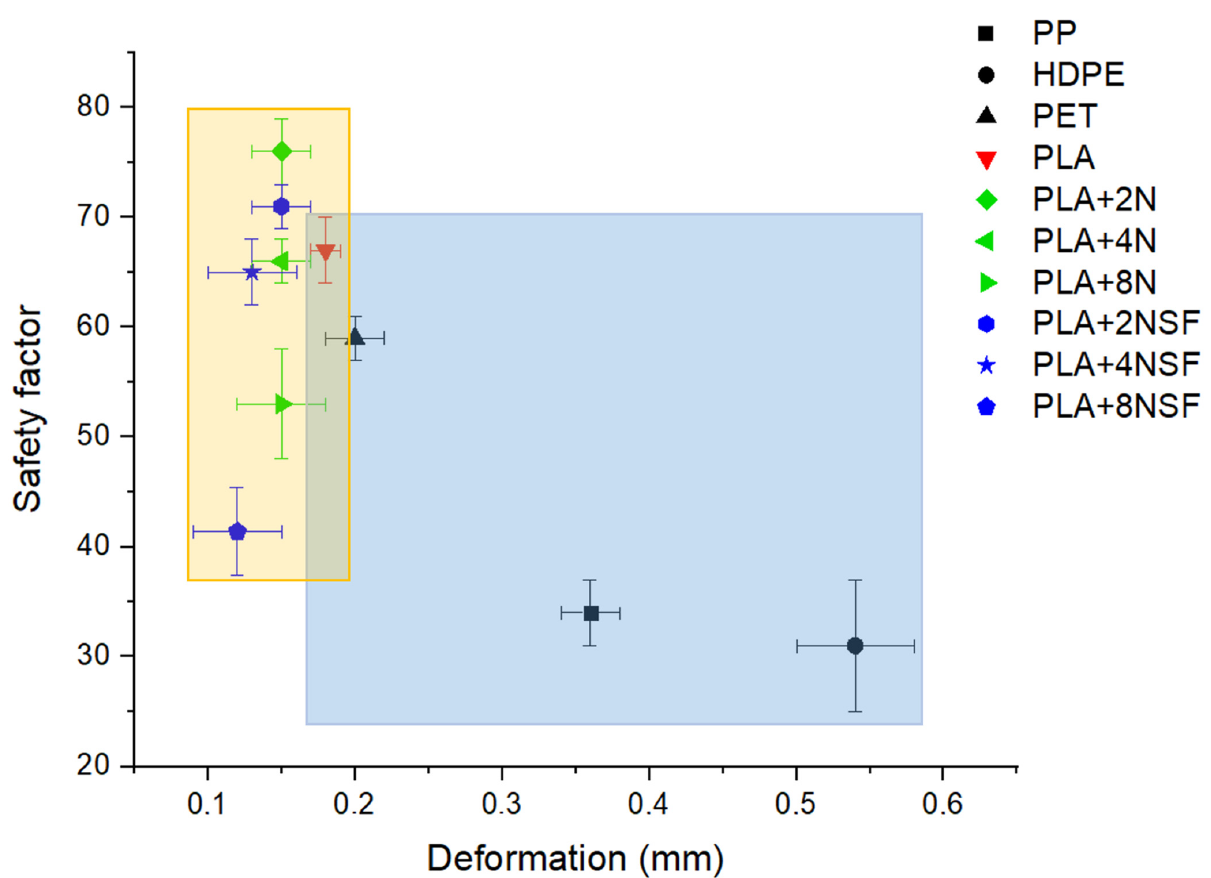
Figure 11. Comparison between commercial polymers and produced nanocomposites in terms of deformation and safety factors. The blue square marks the results for common polymers, including PLA, while the orange indicates the composites samples.